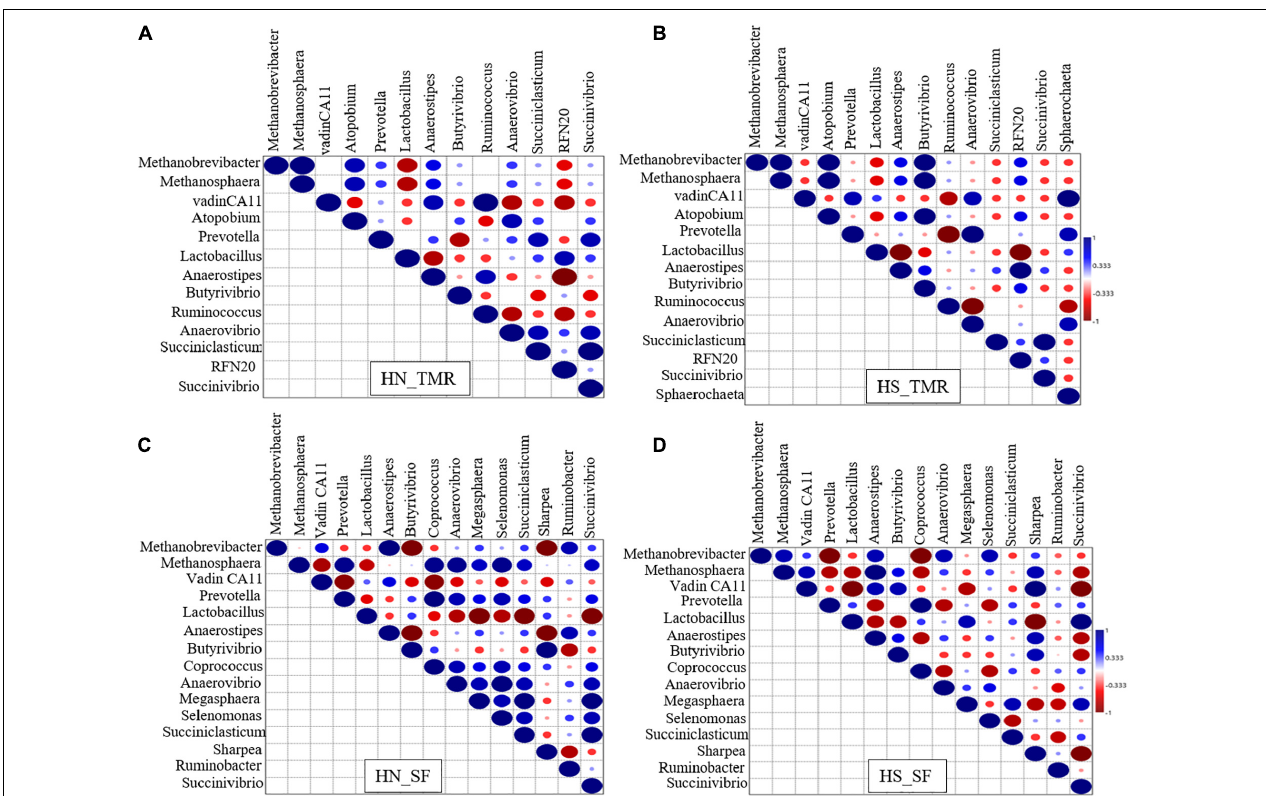
FIGURE 4 | Kendall rank correlation analysis of the co-occurrences of microbial lineages. (A) Hanwoo (HN) steers fed a total mixed ration (TMR) diet. (B) Holstein (HS) steers given TMR diet. (C) Hanwoo (HN) steers given separate feed (SF) diet. (D) Holstein (HS) steers given SF diet. The genera were included in the matrix if they had a relative abundance of at least 0.01% in at least one steer. Correlation strength is indicated by the intensity of the colour. The scale colours denote whether the correlation is positive (closer to 1, blue Spheres) or negative (closer to − 1, red Spheres). Big sphere indicates that the correlation is significant ( P < 0.05).